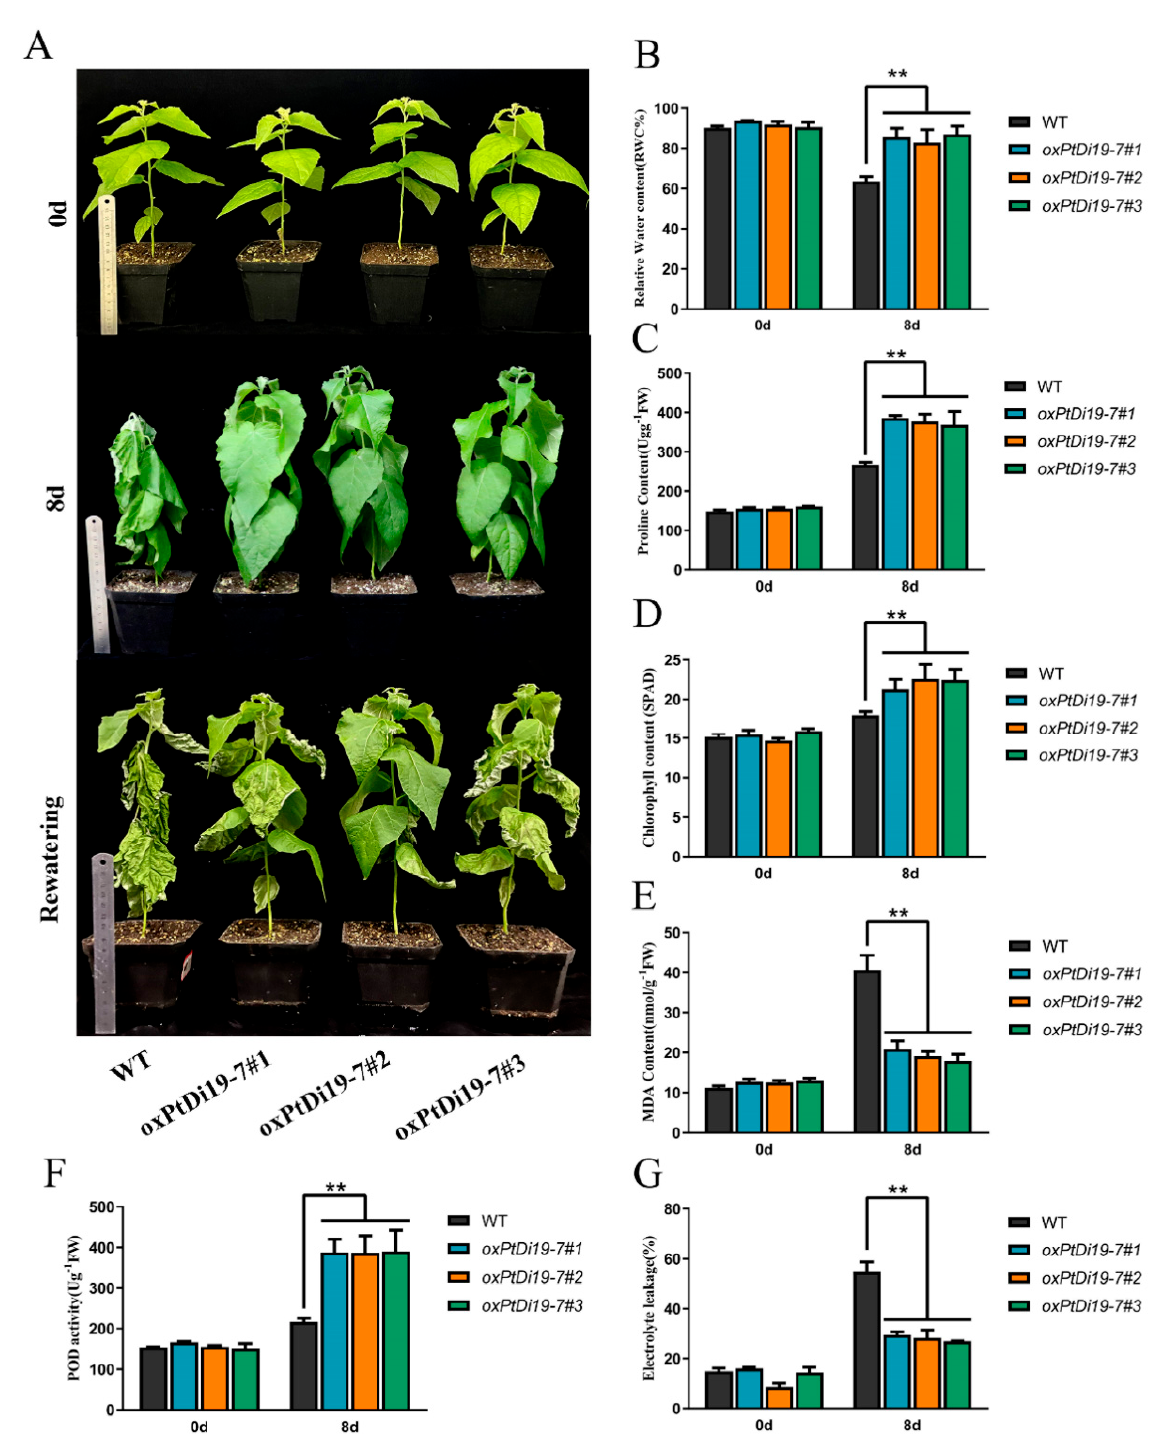
Figure 9. PtDi19–7 improved drought resistance in poplar. ( A ) One-month-old wild-type 84K poplar and oxPtDi19–7 lines were withheld water for 8 days to induce dehydration. After dehydration for 8 days, the representative images were taken. ( B ) Relative water content of the leaves. ( C ) Proline contents. ( D ) Chlorophyll content. ( E ) MDA content. ( F ) POD activity. ( G ) Electrolyte leakage. A p -value of <0.01 was considered to be extremely significant